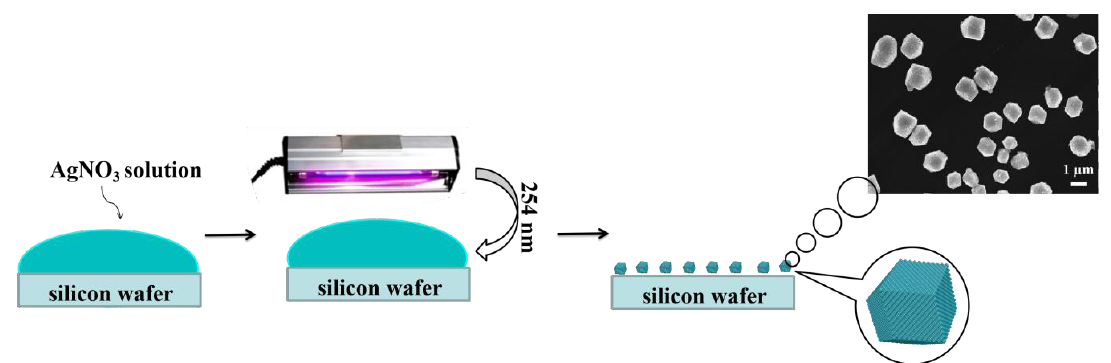
Scheme 1. Schematic diagram illustrating the synthesis process of screw-dislocation-driven hierarchical superstructures of Ag-Ag 2 O-AgO nanoparticles (HSANs).